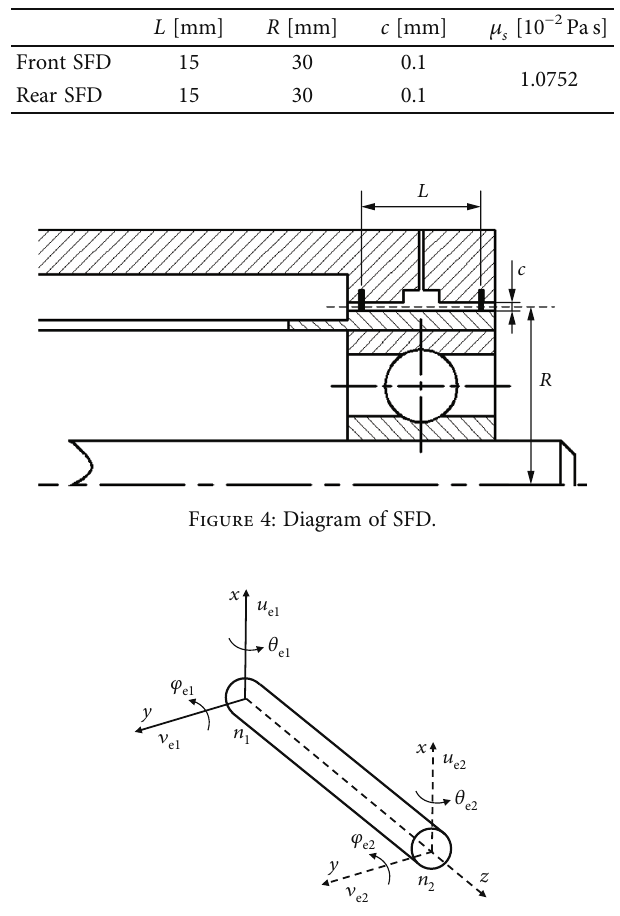
Figure 5: Diagram of the Timoshenko beam element